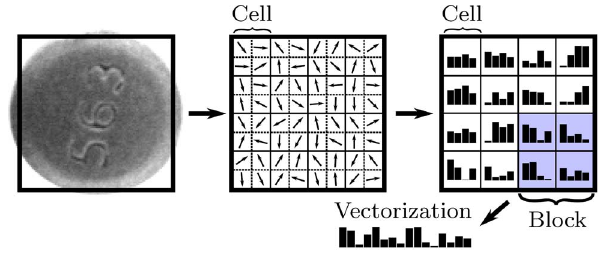
Figure 3. Histograms of Oriented Gradients. The detection window is subdivided into spatial cells, which are then concatenated into larger blocks.